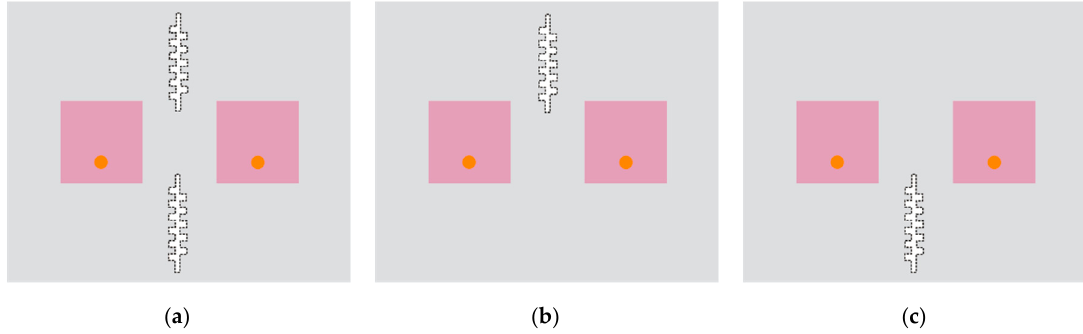
Figure 8. Proposed DGS and zigzag groove unit positions. ( a ) Proposed DGS; ( b ) Zigzag groove unit on top; ( c ) Zigzag groove unit at bottom.